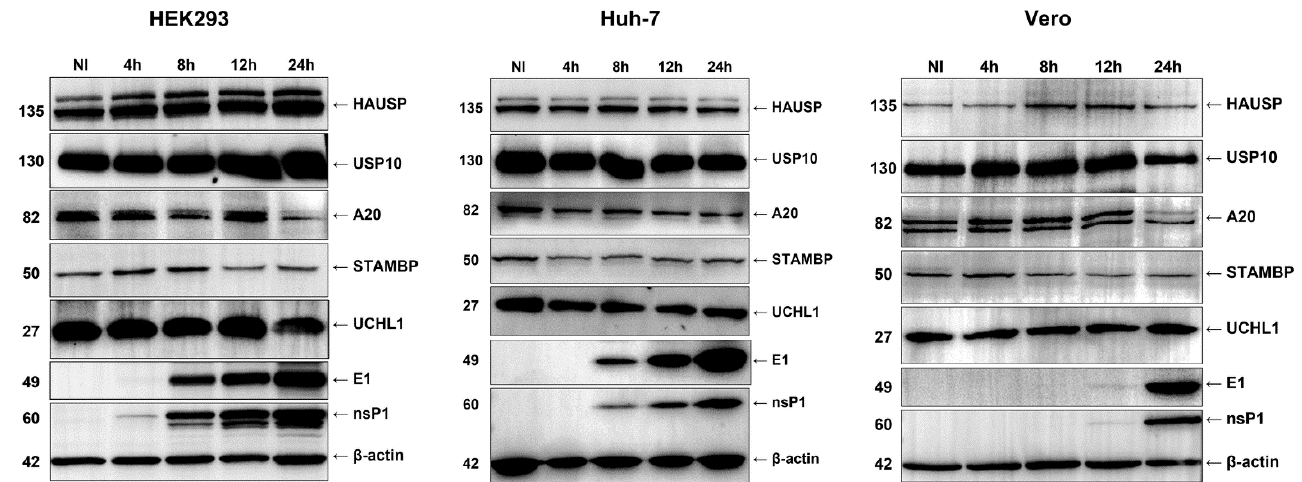
Figure 5. Expression of deubiquitinating enzymes throughout CHIKV infection. Cells were infected with CHIKV for 1 h; the inoculum was removed and replaced with fresh media; then, cells were collected at the indicated times. Expression of different DUB proteins was assessed using Western blot with antibodies against HAUSP, USP10, A20, STAMBP, and UCHL1, whereas viral protein levels were evaluated using antibodies against E1 and nsP1. β -actin was used as a loading control.